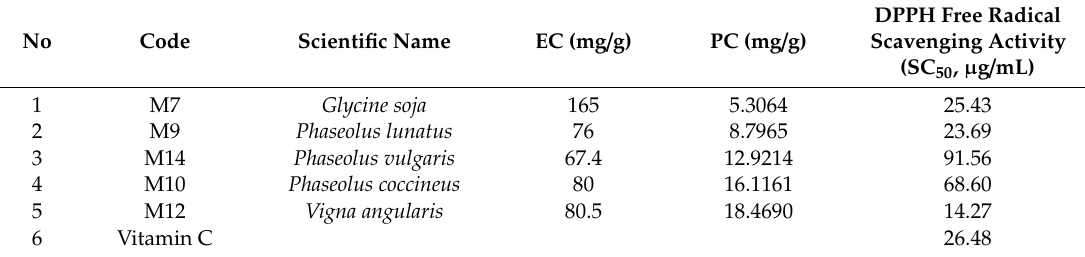
Total extractable compounds (EC) [mg / g], total phenolic compounds (PC) [mg / g], and 2,2-diphenyl-1-picrylhydrazyl (DPPH) free radical scavenging activity of methanol extracts of five seed samples (SC50) [ µ g /